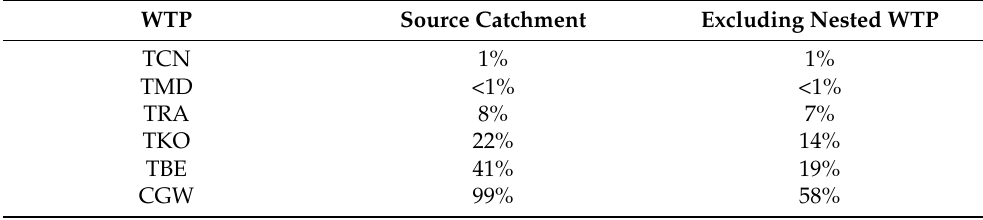
Table 5. Proportion of budget allocation to each subcatchment where ‘Source catchment’ represents total contributing area, and ‘Excluding nested WTP’ represents the proportion of catchment only contributing to the referenced WTP.